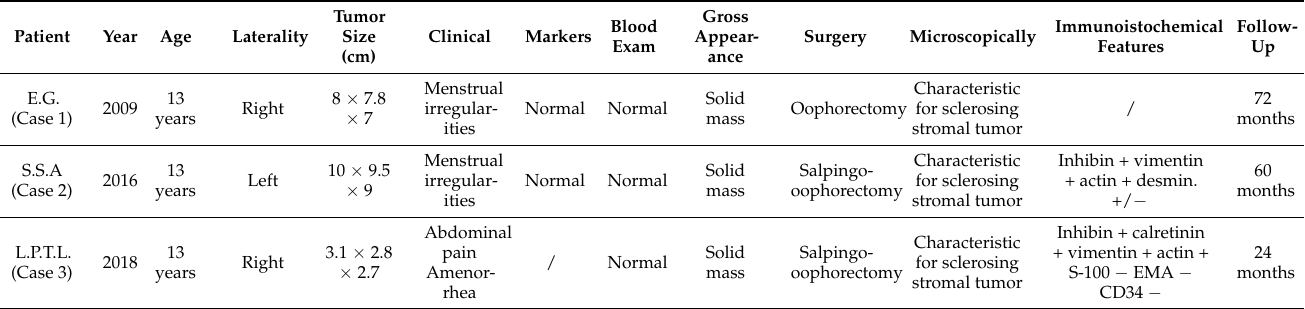
Table 1. Case series. List of our case series and summary of their characteristics: tumor size, laterality, age of the patient, clinical manifestations at entry, markers, blood test, macroscopic appearance, type of surgery performed, and microscopic characteristics.